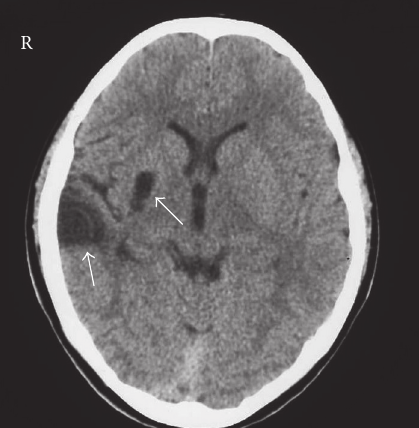
Figure 1: Brain lesion in computed tomography (CT). Low-density areas (arrows) in the right putamen and temporal lobe are observed.